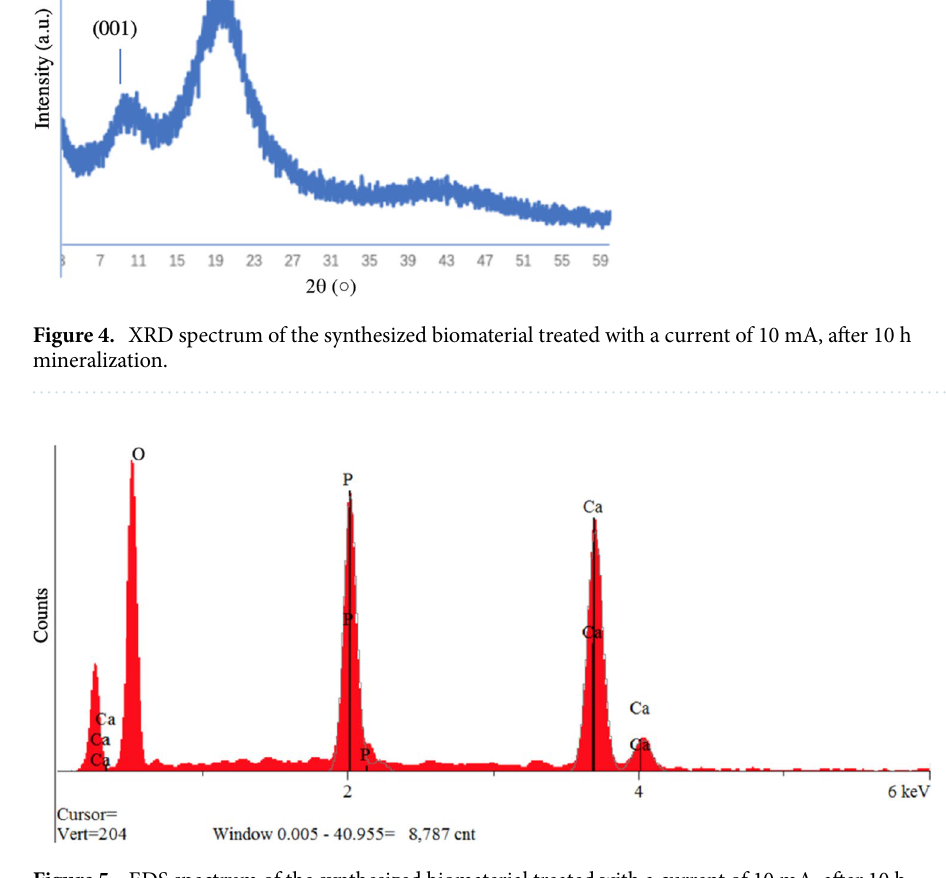
Figure 5. EDS spectrum of the synthesized biomaterial treated with a current of 10 mA, after 10 h